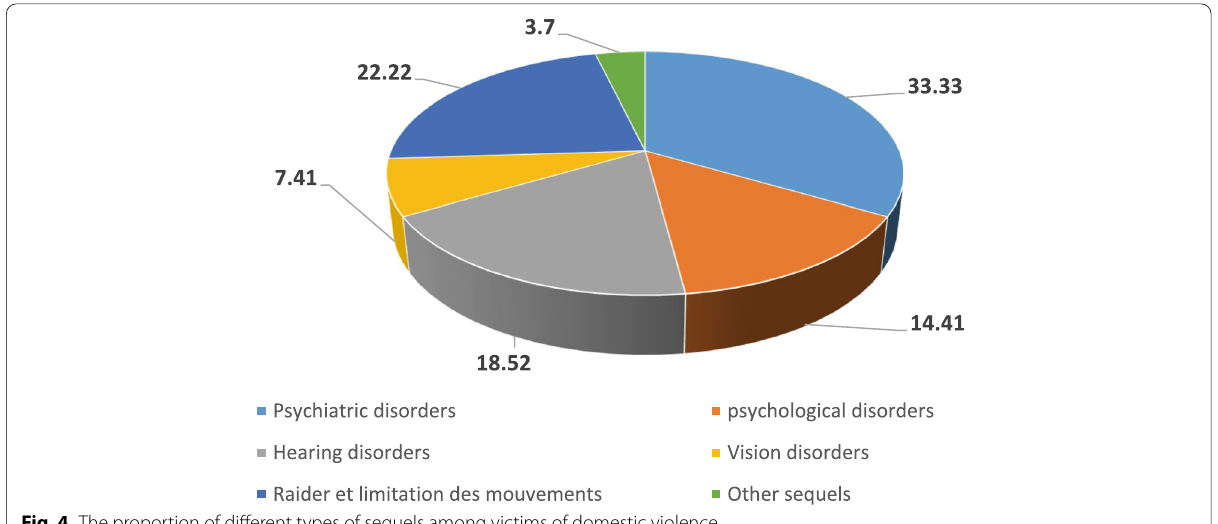
Fig. 4 The proportion of different types of sequels among victims of domestic